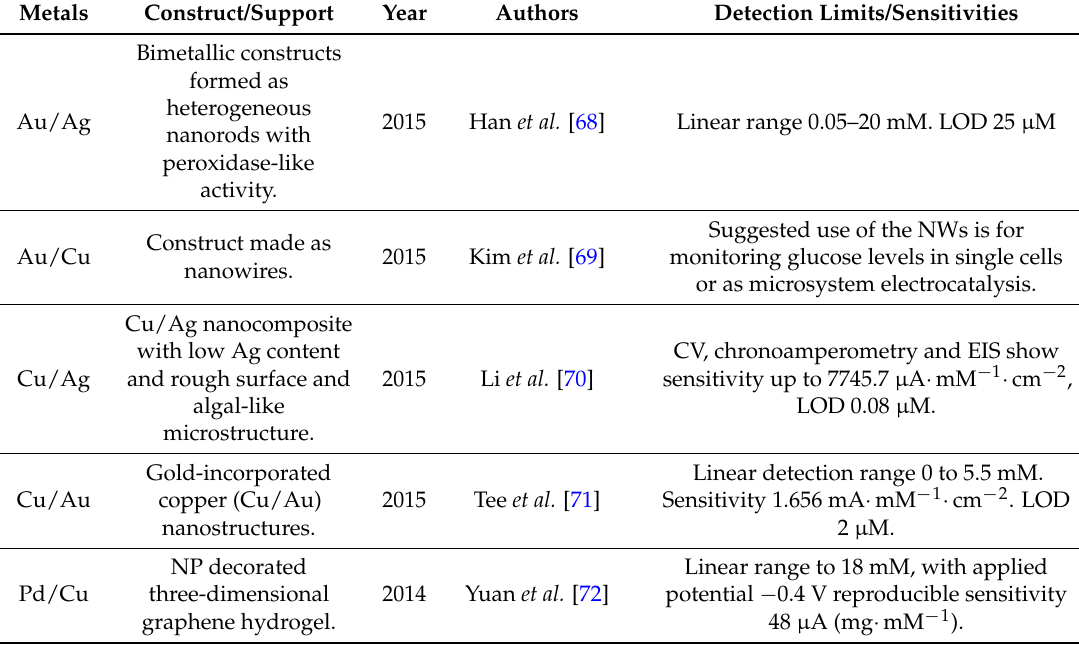
Table 2. Metals and constructs used for glucose